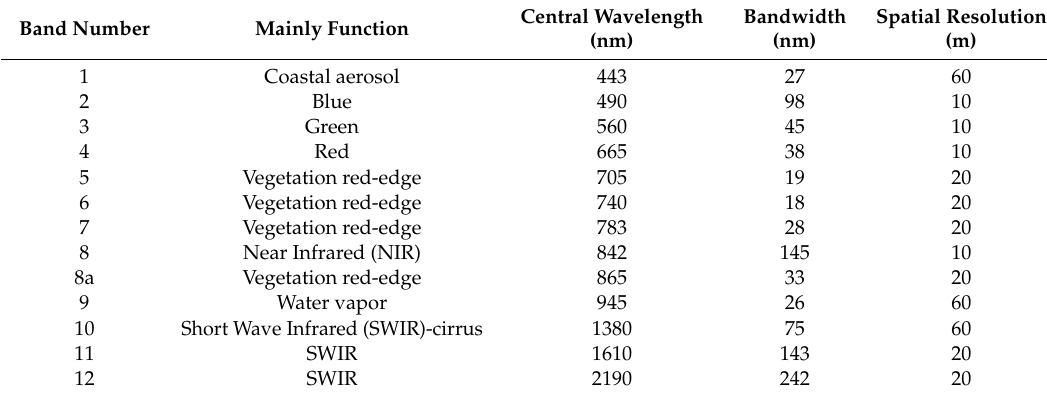
Table 2. Sentinel-2 bands